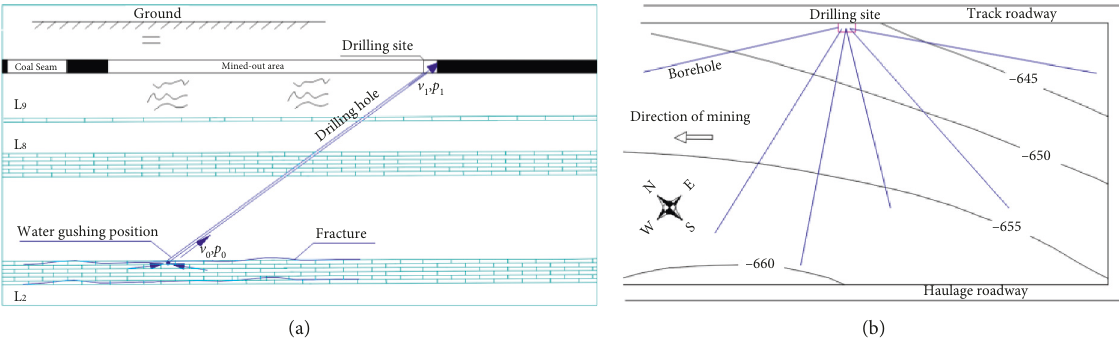
Figure 1: Schematic diagram of aquifer grouting in one drilling site from the roadway to aquifers: (a) a section and (b) plane figure.